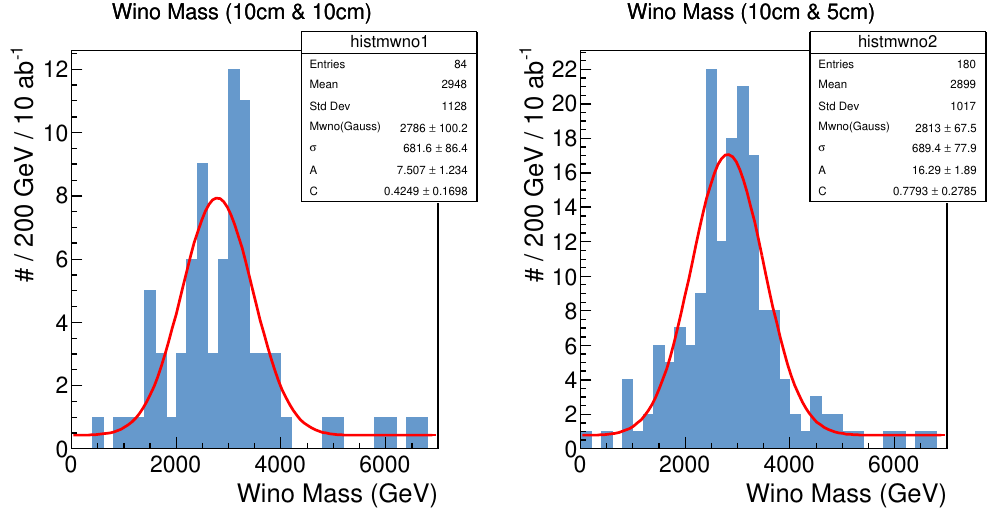
Figure 3 . Distribution of the reconstructed Wino mass for Sample Point 2, taking L (min) (left) and 5 cm (right) in a single experiment with the integrated luminosity of L = 10 ab (cid:0) 1 .